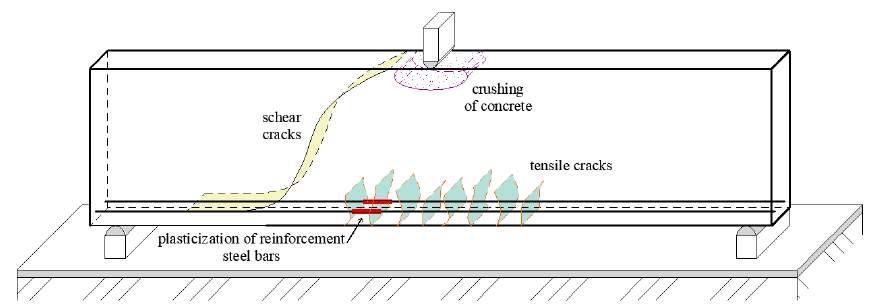
Figure 3. Typical failures of a reinforced concrete beam.